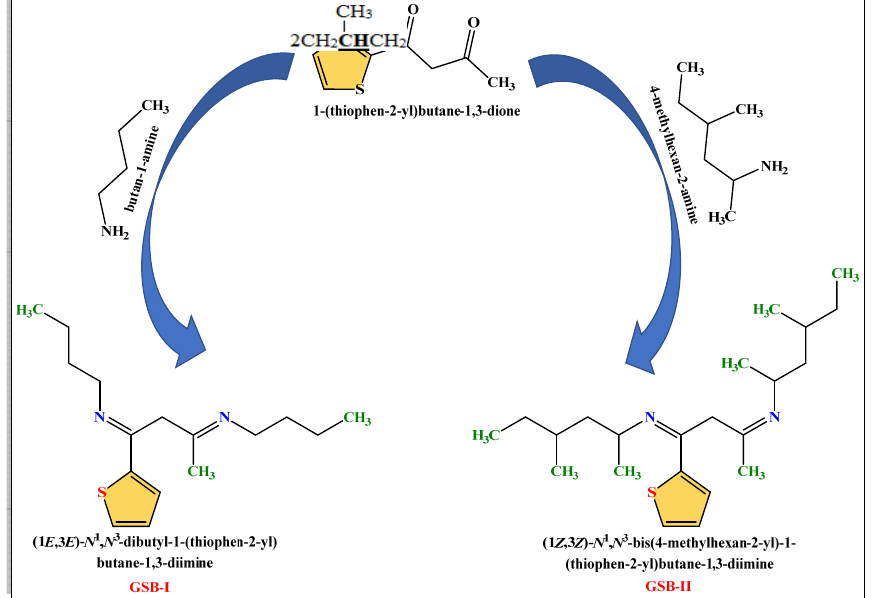
Figure 1. The synthesis route of GSB-I and GSB-II.